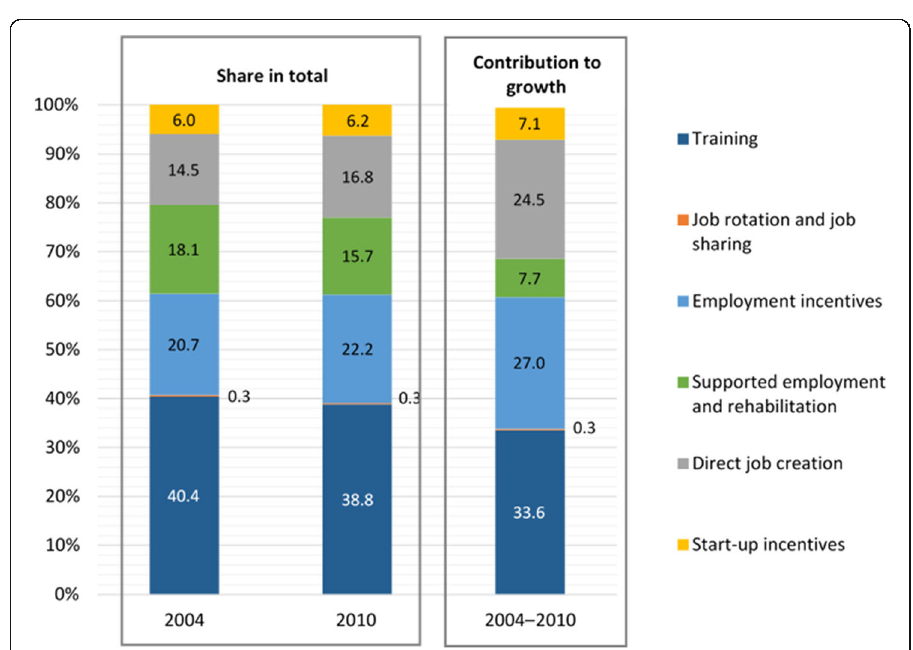
Fig. 2 Share of expenditure by type of ALMP in 2004 and 2010 and in the change between 2004 and 2010 (percentages of total ALMP expenditure, excluding PES and administration). Source: Author ’ s calculations based on OECD.Stat